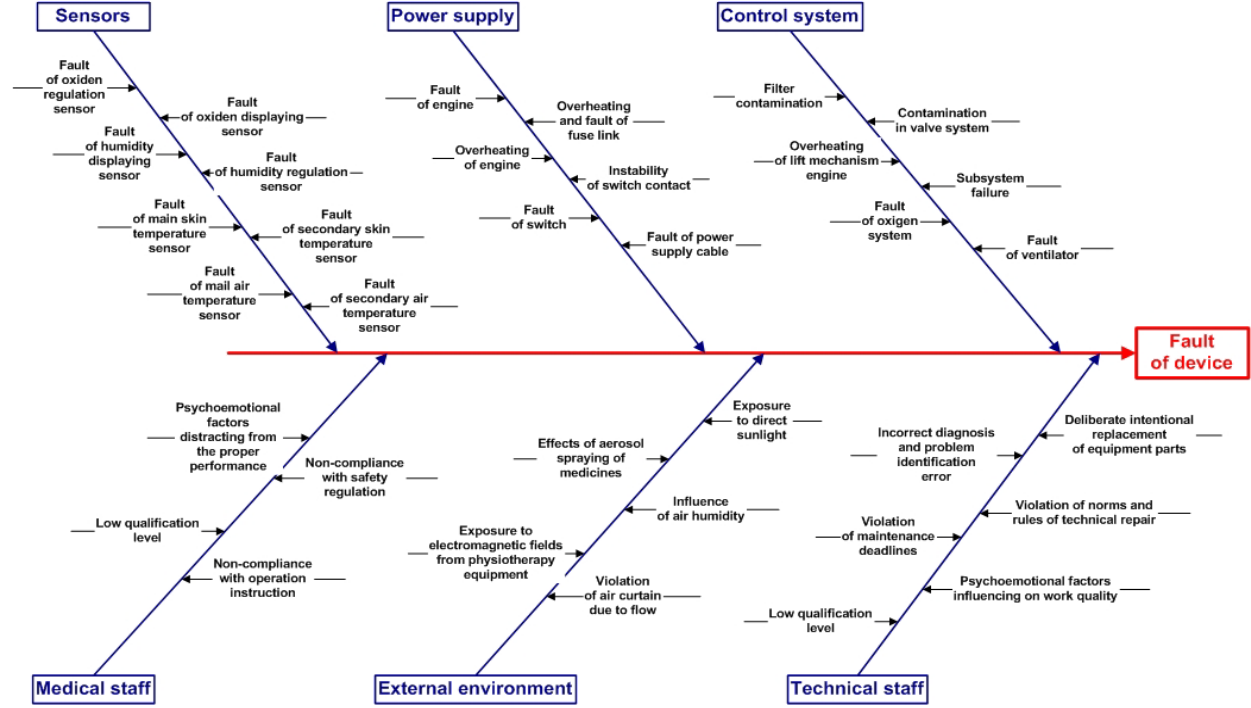
Figure 5. Diagram of cause-and-effect factor relationships for the appearance of possible malfunctions.